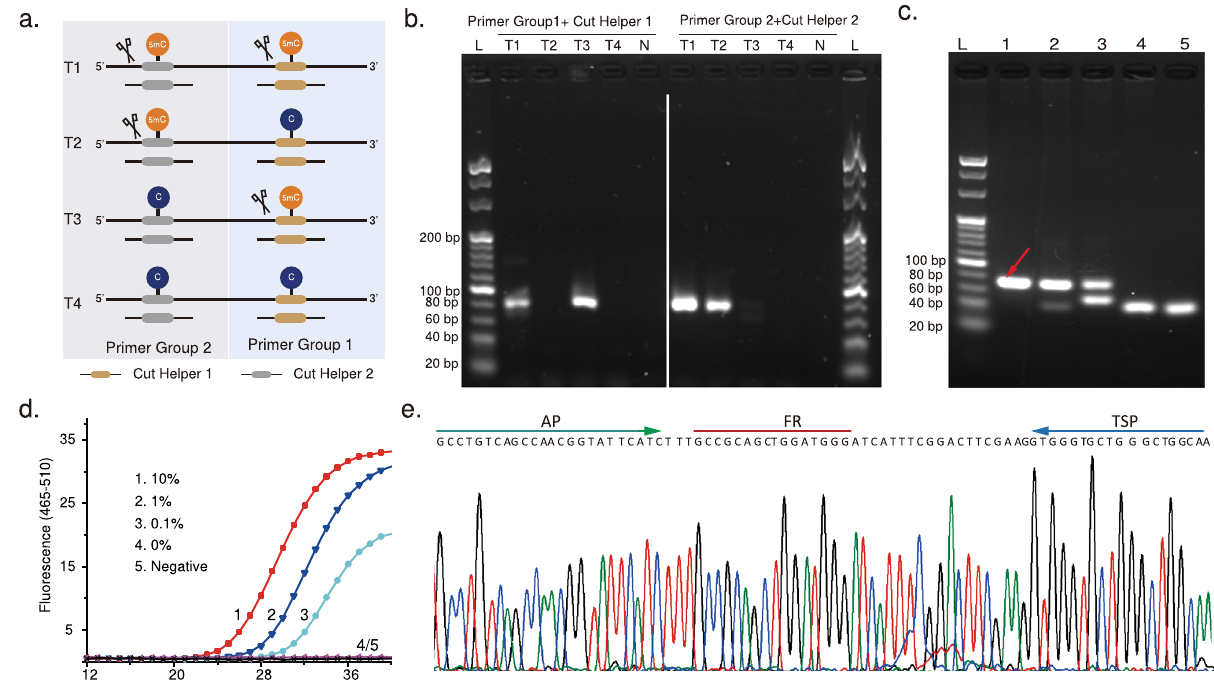
Fig. 2 | Location-speci fi c detection of methylation. Location-speci fi c detection of methylation ( a ) scheme describing the mechanism used for location-speci fi c detectionof5-mC; b Anagarosegelshowingtheampli fi cationproductsgenerated withdifferentcuthelpersequences(requiredforthefunctionalityoftheenzymes) and location-speci fi c primer sets. Four arti fi cial templates were designed with the same sequence but contained two methylated CpG sites (distance=20bp), which can be digested using MspJI (mCNNR). L, 20bp ladder; N, no template, as a negative control.Cuthelper1 andprimersets1weredesignedforthe detectionof therighttargetCpGsite;cuthelper2andprimergroup2weredesignedfortheleft oneshownin( a );eachexperimentwasrepeatedindependentlyatleastthreetimes with similar results ( c ) STEM-PCR products of ten times series diluted GlaI-cut